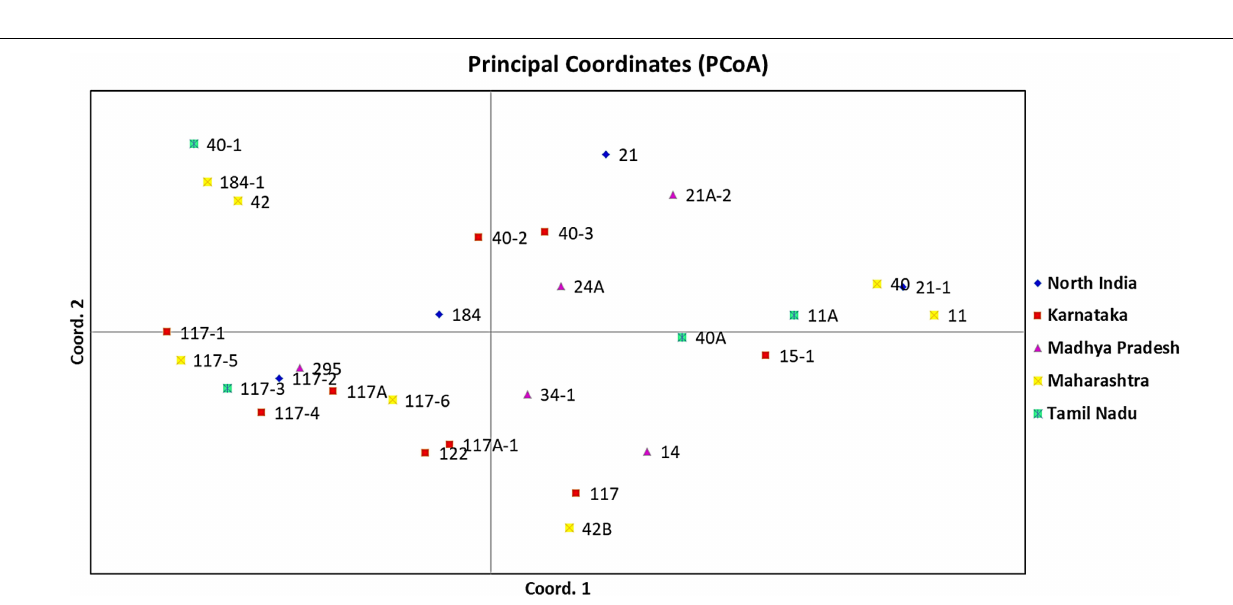
Frontiers in Microbiology |